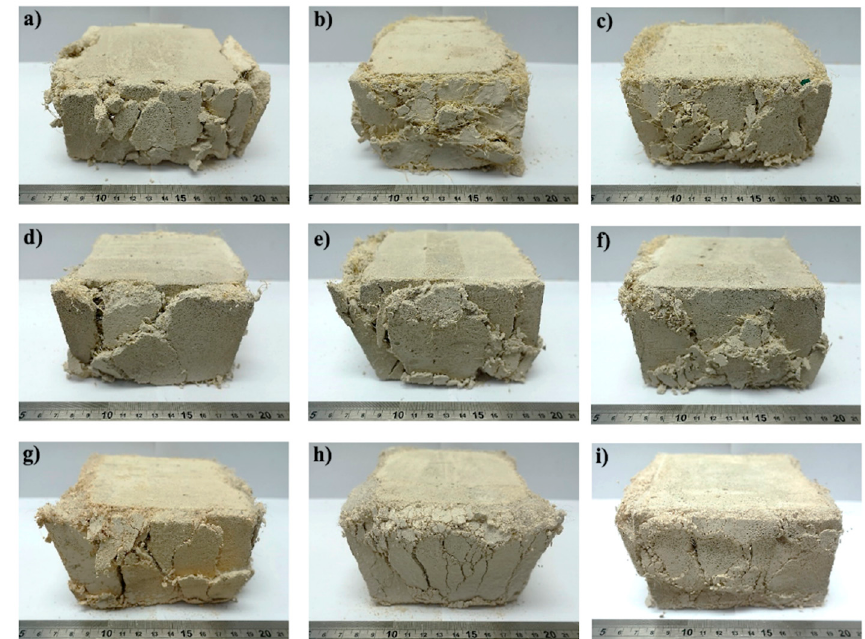
Figure 4. Deformation of the representative foamed concrete specimens at 0.35 compressive strain, reinforced with untreated henequen fiber: ( a ) H0.5FC; ( b ) H1.0FC and ( c ) H1.5FC; with treated henequen fiber: ( d ) HT0.5FC; ( e ) HT1.0FC and ( f ) HT1.5FC and with PP fiber: ( g ) PP0.5FC; ( h ) PP1.0FC and ( i ) PP1.5FC.